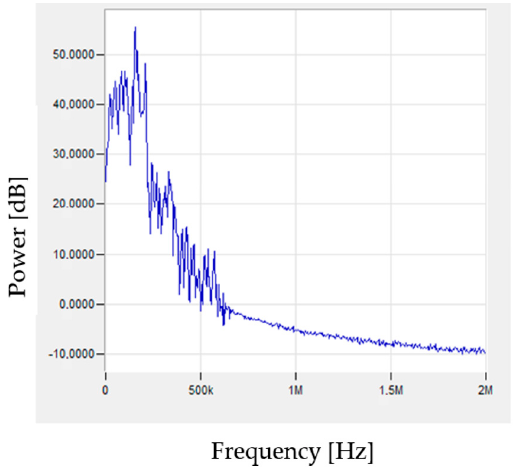
Figure 10. Example of signal, after FFT analysis, characteristic for cracking of fibres. Table 2. Summary of the analysis of the materials degradation.